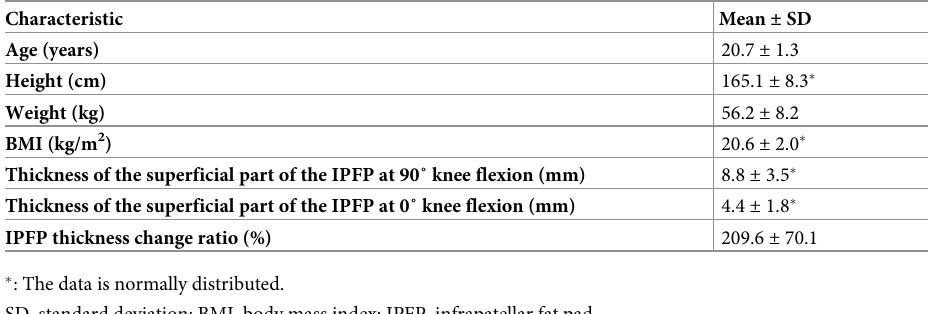
Table 1. Characteristics of the